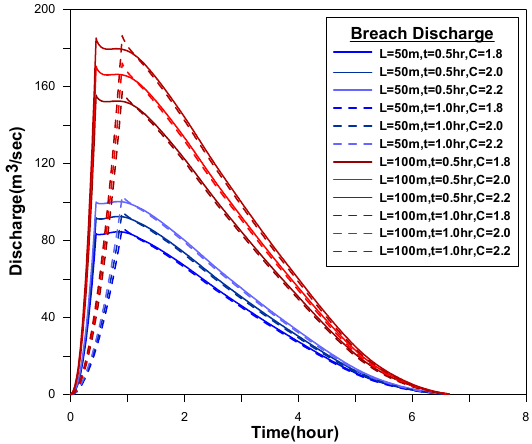
Figure 8. Breach discharge hydrographs for different parameter sets at Levee #1 (L: levee failure width, t: failure duration, C: discharge coefficient).